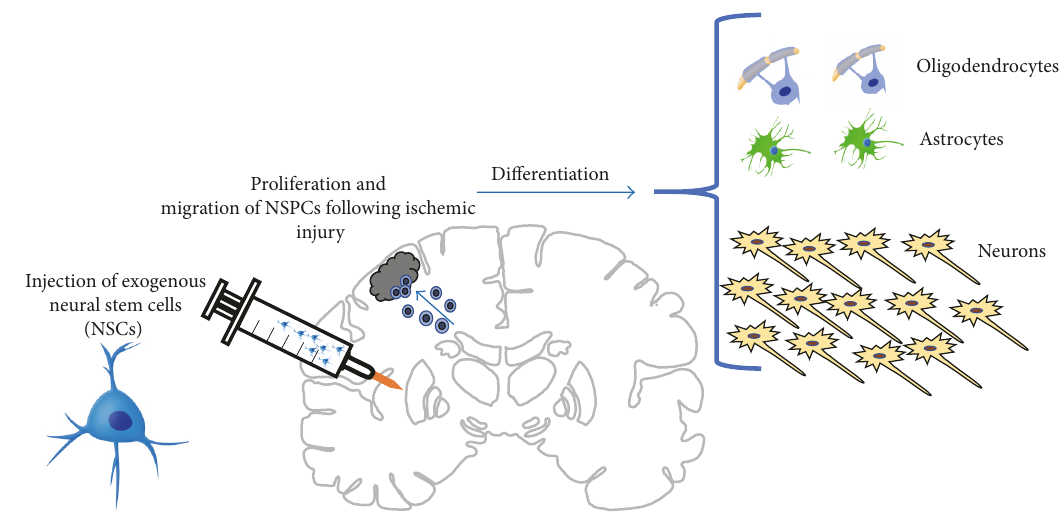
Figure 4: This fi gure demonstrates the e ff ects of NSC transplantation following ischemic injury in a rat brain. Exogenous NSCs promote increased migration and proliferation of endogenous NSCs. In addition, there is increased di ff erentiation into neurons compared to glial